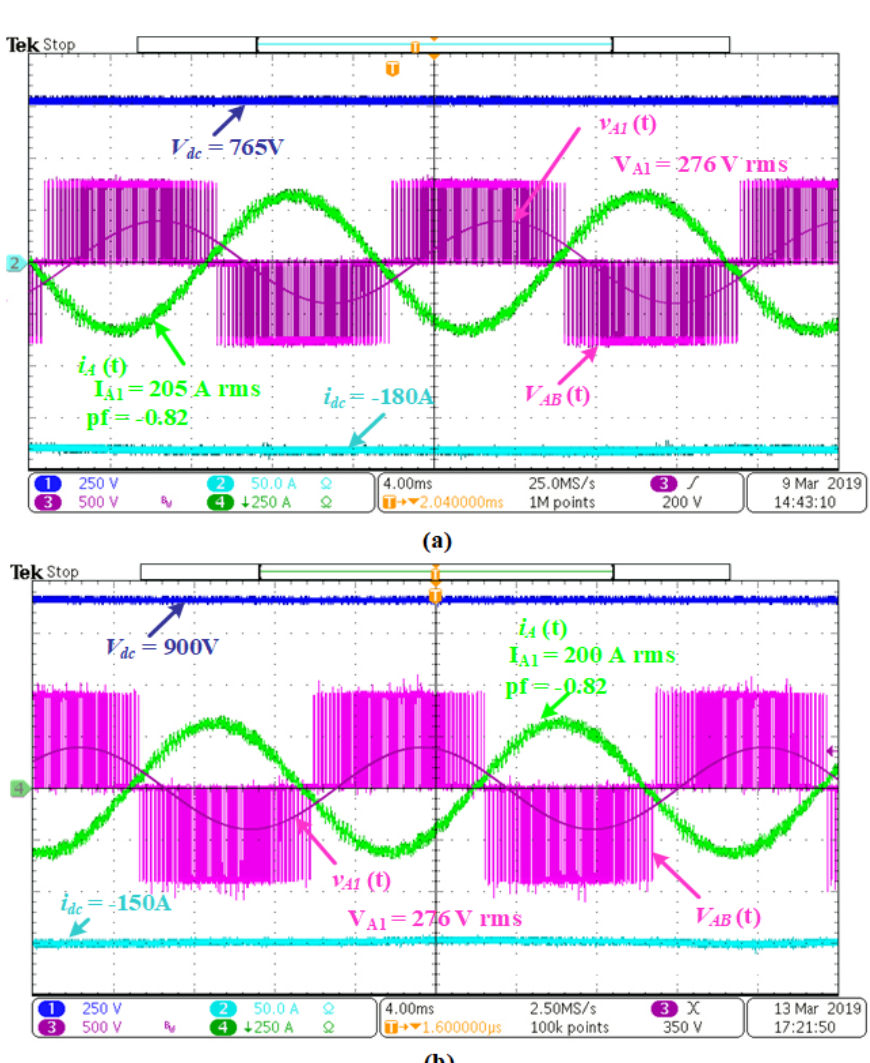
Figure 18. Snapshots of output DC link current, I dc , and DC link voltage, V dc , and AC input voltage, v AB , and current, i A , waveforms corresponding to f s = 60 Hz, f sw = 10 kHz as recorded by Tektronix MDO3034 oscilloscope at a sampling rate of 1 MS/s/channel while traction motor drive is operating in regenerative braking mode. ( a ) The traction converter operating in the rectification mode absorbs 168 kVA at 0.82 pf from the traction motor operating in the generation mode and delivers 138 kW to the DC link at V dc = 765 V, and ( b ) the traction converter operating in the rectification mode absorbs 165 kVA at 0.82 pf from the traction motor operating in the generation mode and delivers 135 kW to the DC link at V dc = 900 V.